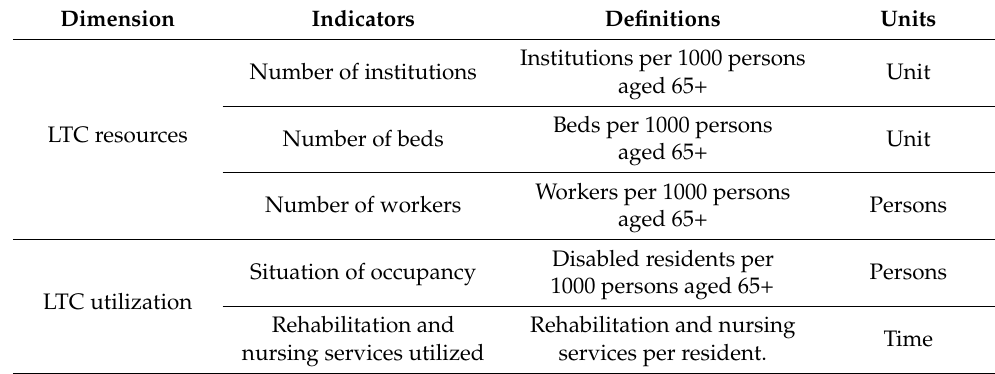
Table 1. Evaluation index system for LTC resource distribution and